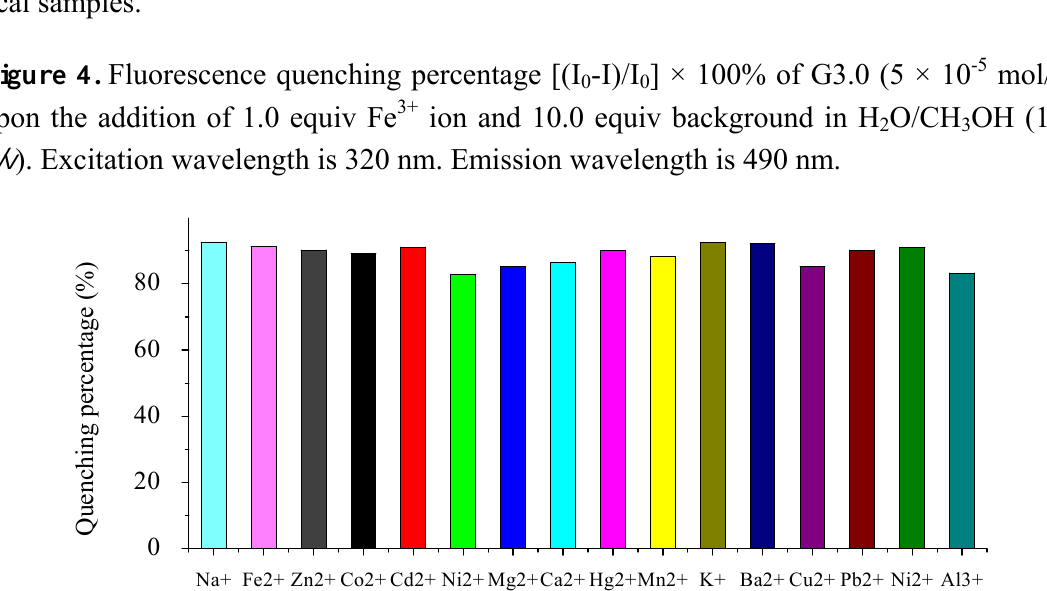
Figure 4. Fluorescence quenching percentage [(I